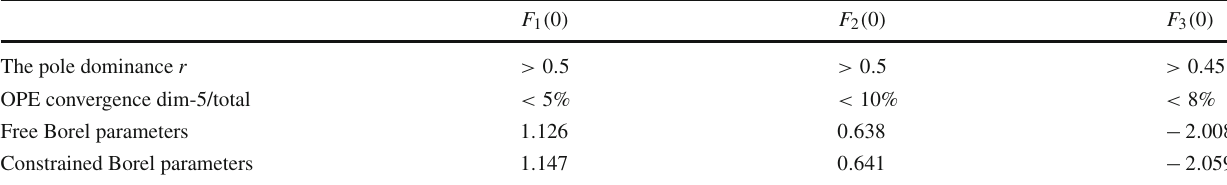
Table 5 The quantitative criteria of the pole dominance and OPE con- vergence,andacomparisonoftheresultsof F i ( 0 ) obtainedbythesetwo different ways to determine Borel parameters. When the Borel param- eters are taken as free, we average the values of F i ( 0 ) within the Borel